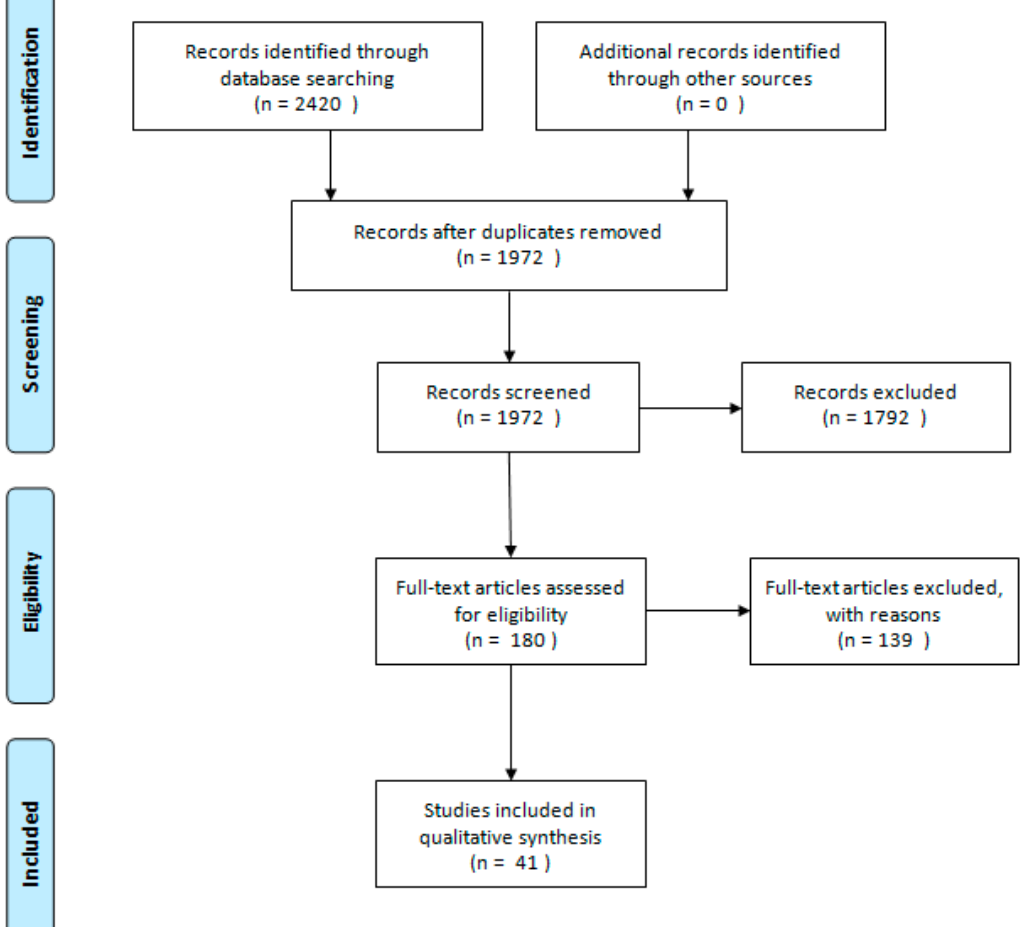
Figure 1. Preferred Reporting Items for Systematic Reviews and Meta-Analyses (PRISMA) flowchart of the literature search and study selection.